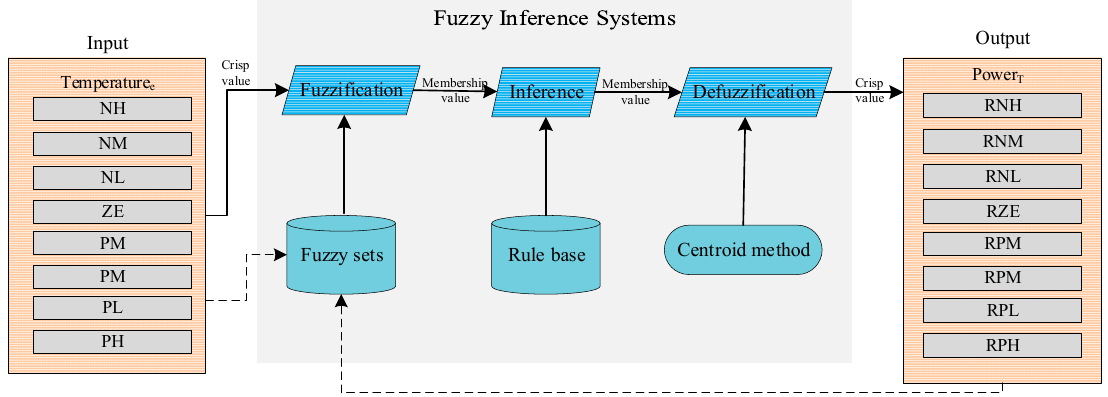
Figure 6. Structure diagram for temperature fuzzy controller.